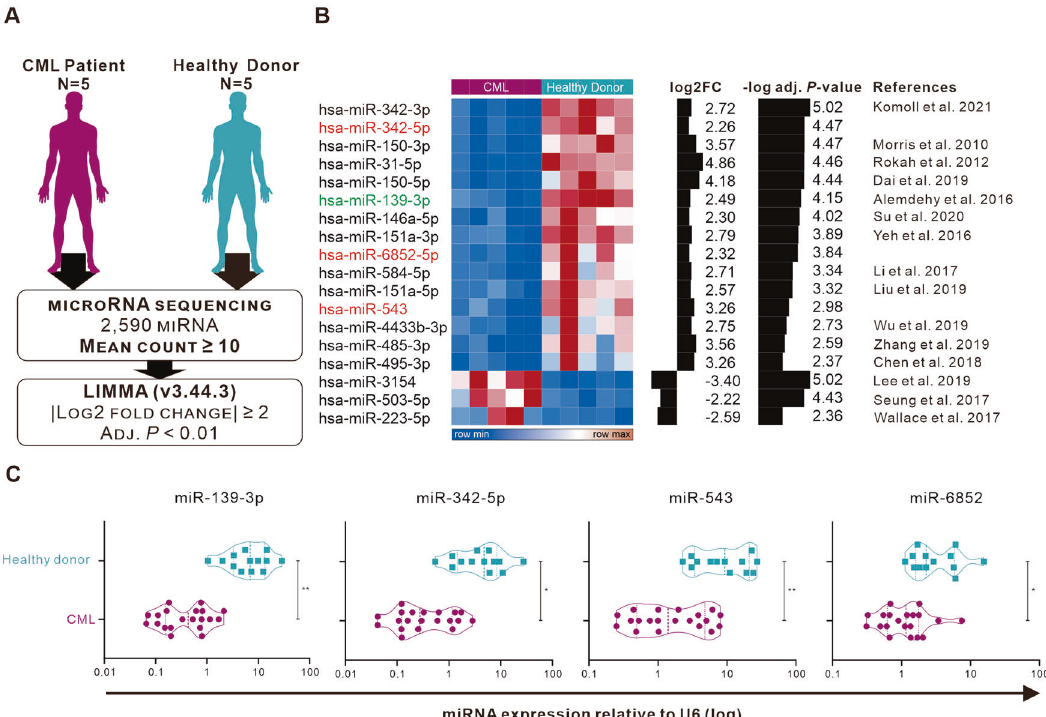
Fig. 1 Comprehensive analysis of miRNAs with abnormal expression in CML patients using miRNA sequencing. A Schematic diagram of the screening process for miRNAs with signi fi cant differential expression using microRNA sequencing data; ( B ) Heat map of miRNA expression of 18 miRNAs with signi fi cant differences of 4-fold or more. The red text indicates that the candidate miRNA has not been discussed for its potential mechanism or role in leukemia. Green text means that the miRNA has been con fi rmed in several papers for its role in leukemia. C The expression of candidate miRNAs in PBMC of CML patients and healthy donors was con fi rmed by qPCR, and U6 was used as an internal control. Each data represents mean ± SD from independent experiments performed in triplicate. Statistical signi fi cance analysis was performed with Student ’ s t -test. * P < 0.05; ** P <